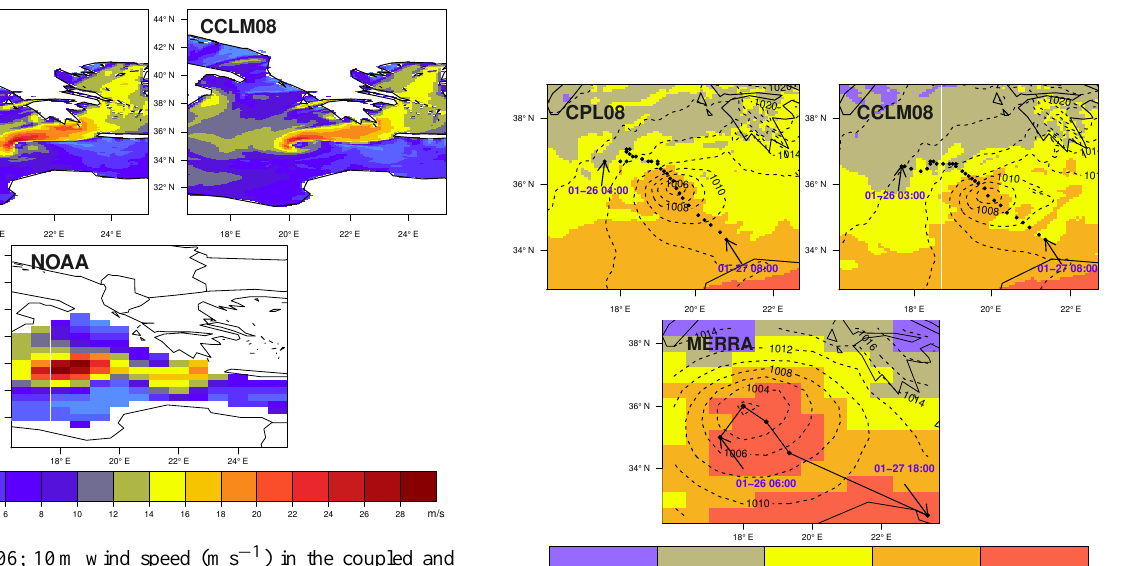
Figure 11. ME06; 10m wind speed (ms − 1 ) in the coupled and atmosphere-only (0 . 08 ◦ ) simulations and the NOAA “Blended Sea Winds” on 16 January 1995, at 12:00UTC.